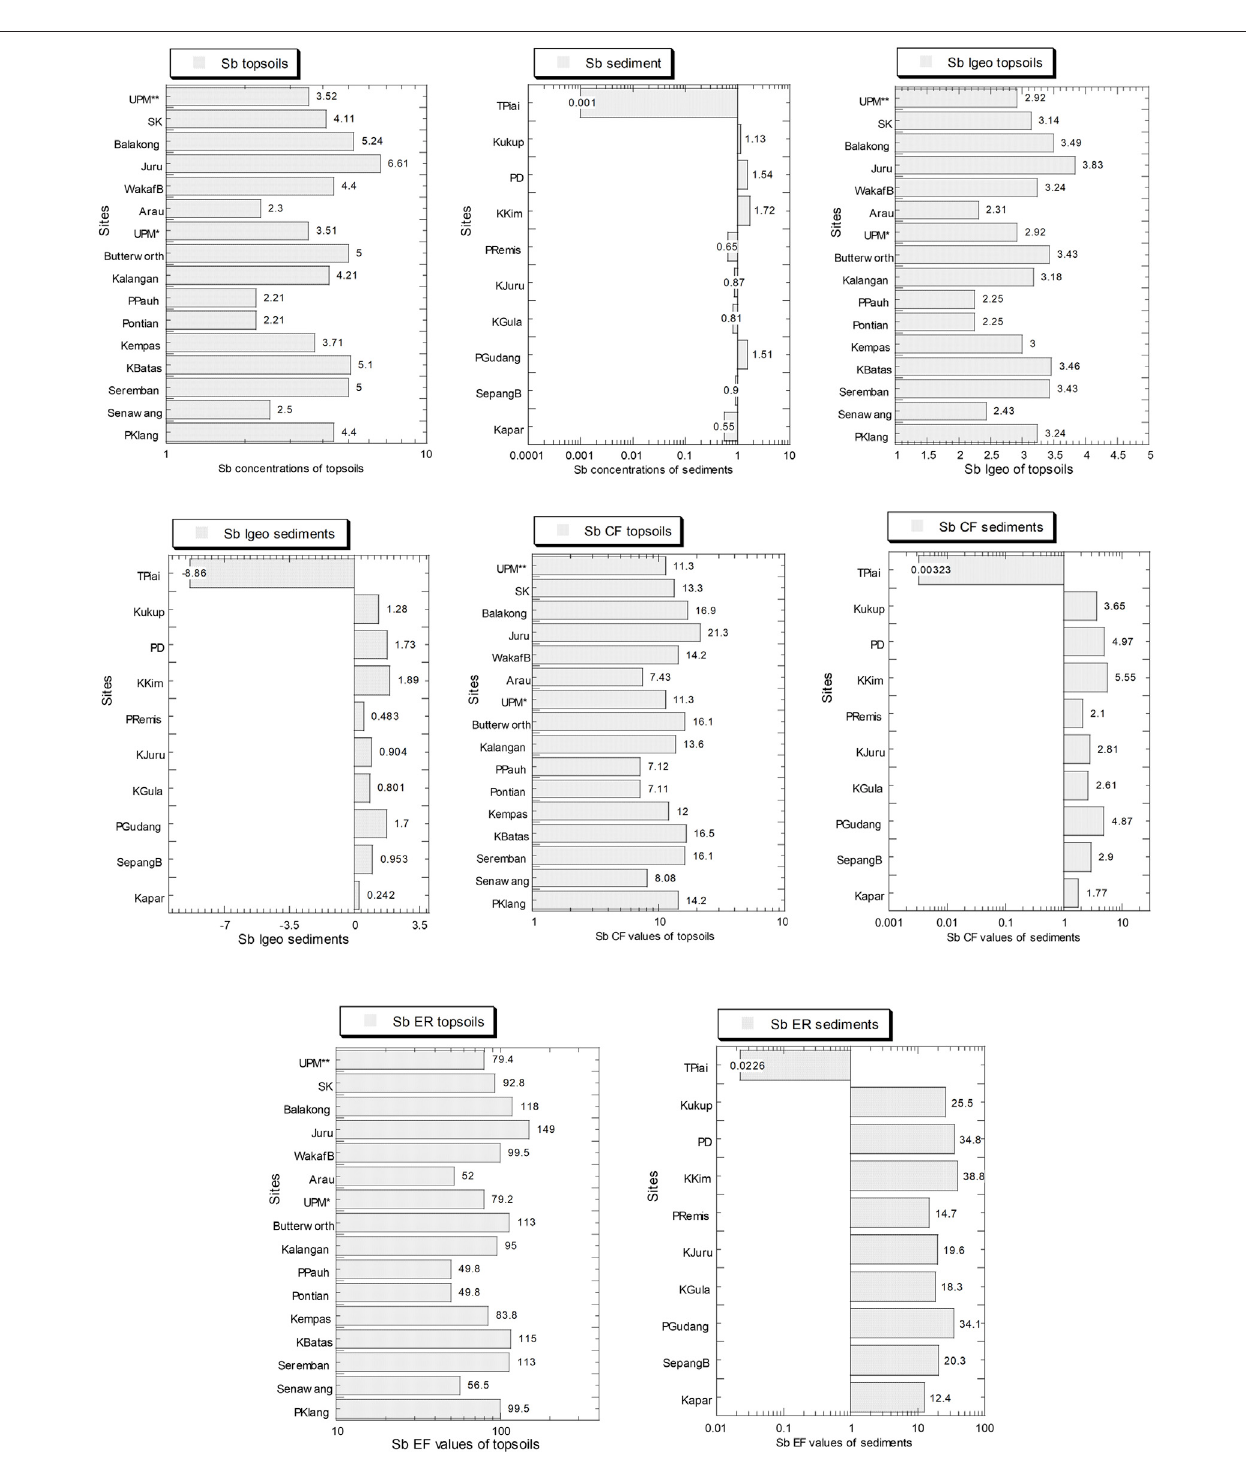
FIGURE 7 | Concentrations of Sb (mg/kg dry weight), geoaccumulation index (I geo ), contamination factor (CF), and potential ecological risk index (ER) for Sb in the topsoils (numbers in white circles (1 – 16) in Figure 1 ; S1 – S16 in Supplementary Table S1 ) and mangrove sediments (numbers in black circles (1 – 10) in Figure 1 ; M1 – M10in SupplementaryTableS1 )fromPeninsularMalaysia.Allthe X -axesarebasedonalogarithmicscale,exceptforthe X -axesofI geo valueswhicharebasedon a linear scale.